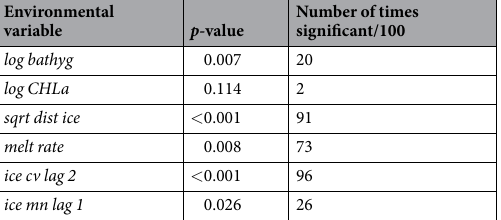
Environmental variable p -value